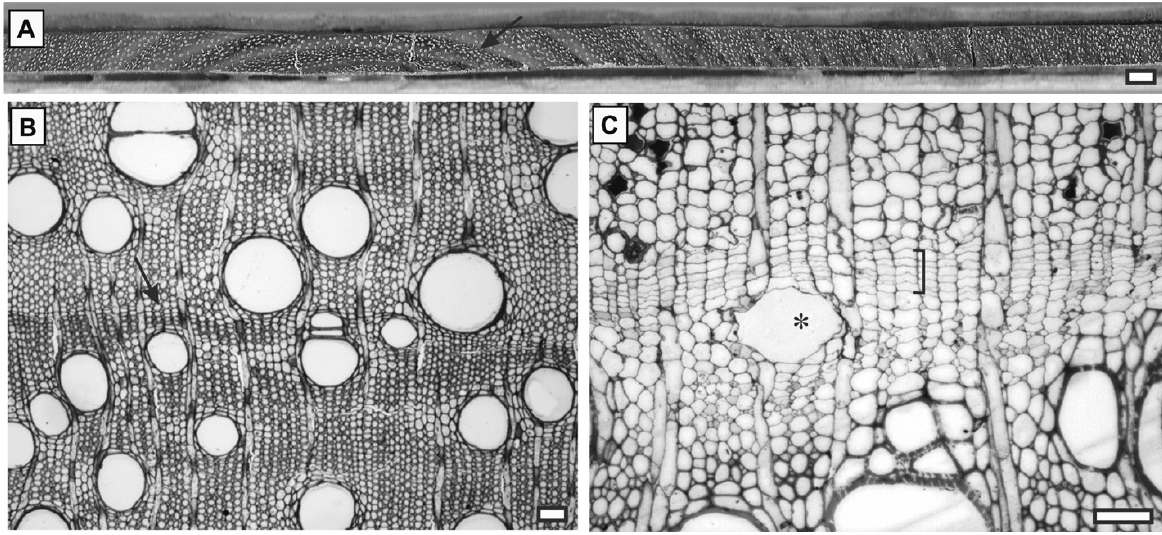
Figure 1 - Growth rings in Centrolobium robustum (Vell.) Mart. ex Benth. (Fabaceae). A: Macroscopical observation in transverse section of wood – note growth rings (arrow) and their variation in width. B: Anatomical observation of wood – note the boundary between two adjacent growth rings (arrow). C: Anatomical observation of a growth ring formation – note cambial zone in the active period (bracket) and a differentiating vessel element (asterisk). Scale bars: A = 1 mm; and B, C = 50